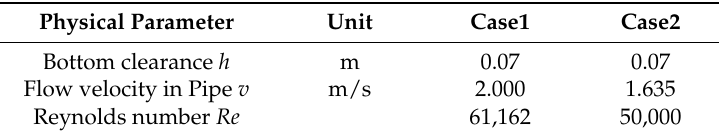
Table 4. Experimental parameters for flow visualization